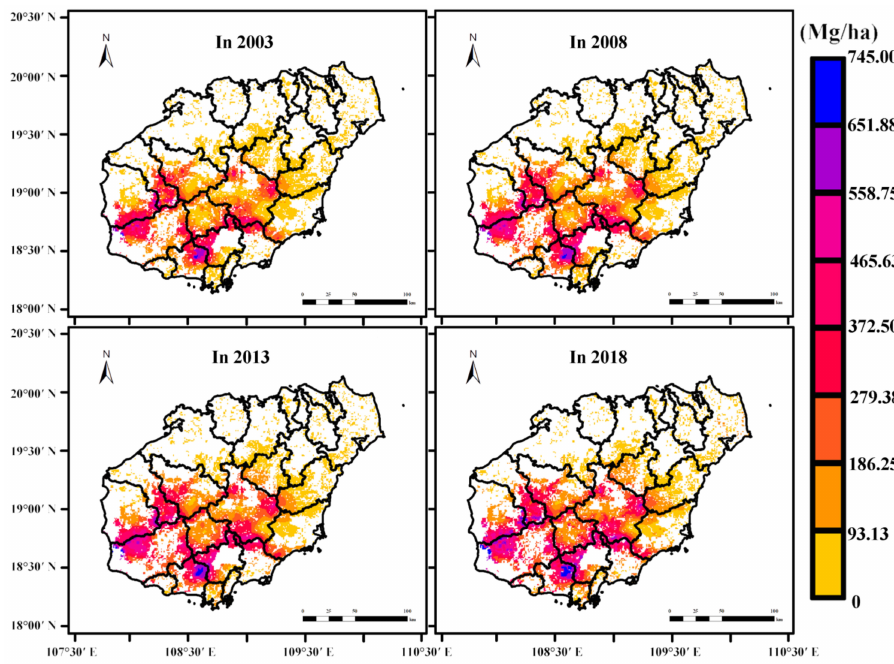
Figure 9. Distribution of forestland area and tropical rainforest biomass in Hainan Island from 2003 to